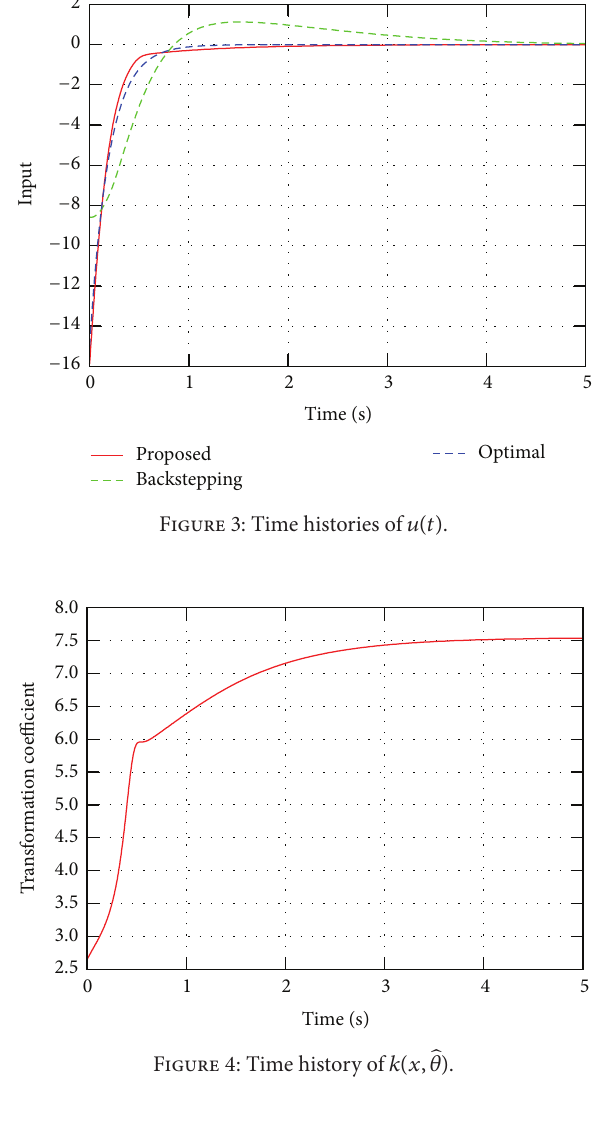
Figure 4: Time history of 𝑘(𝑥,